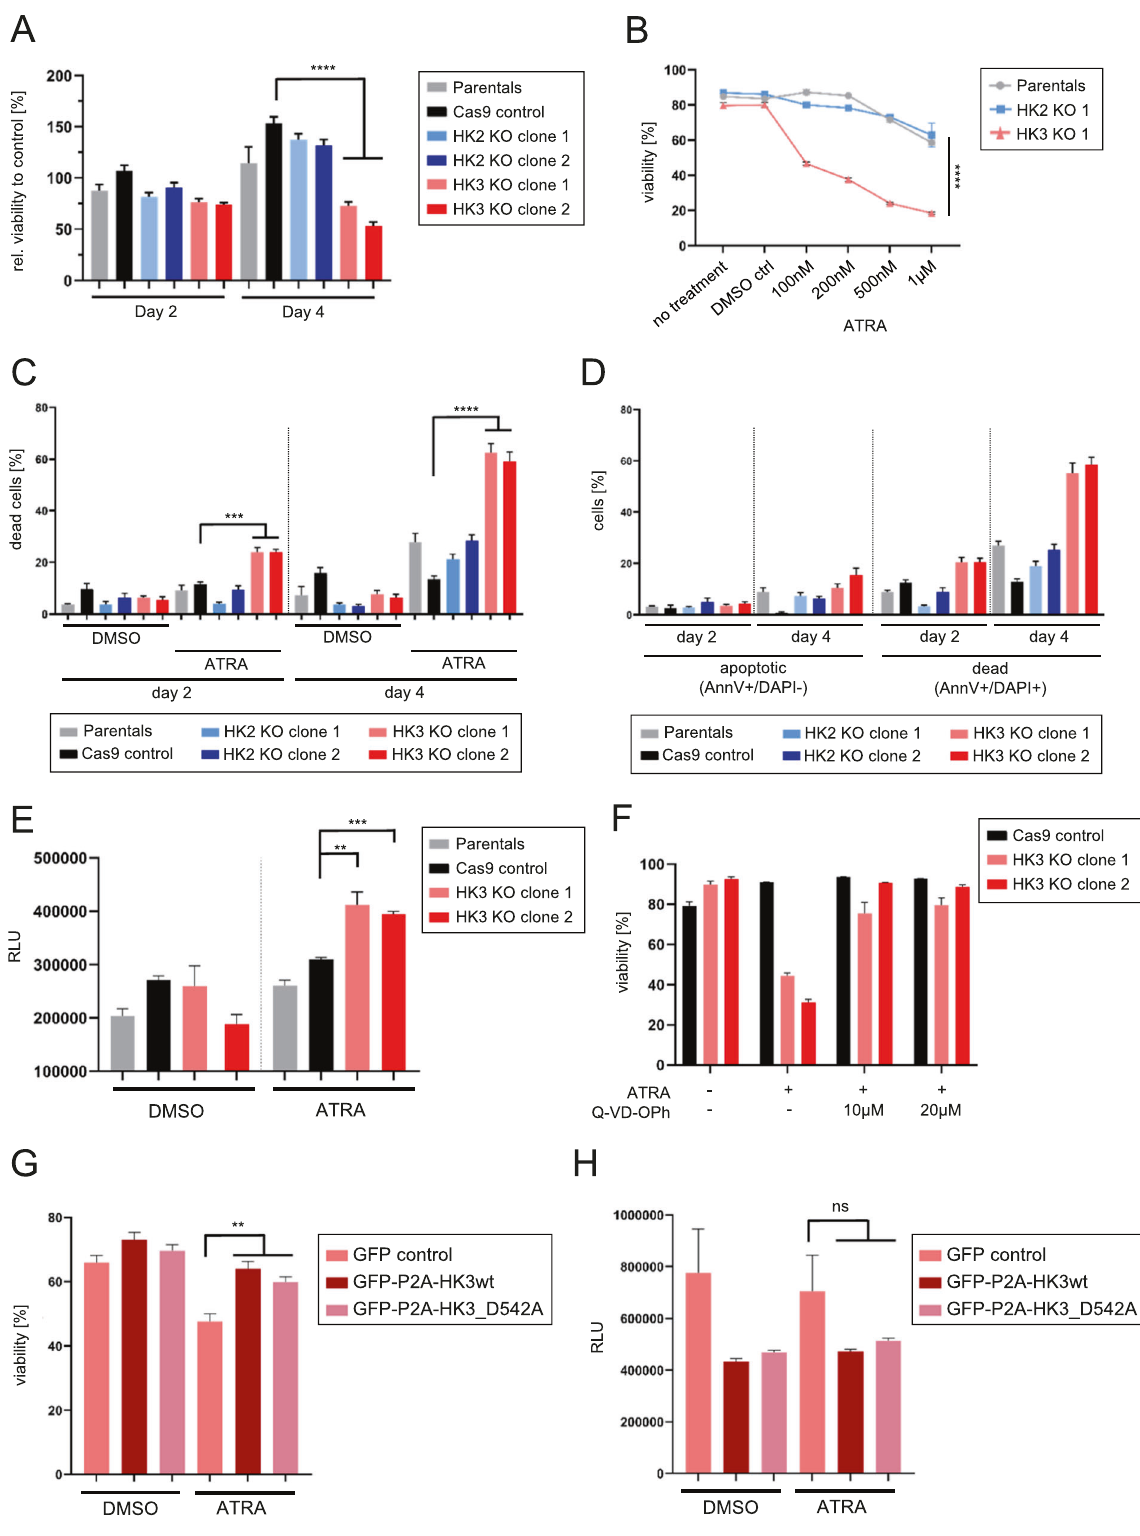
human plasma [36]. Similar glycolytic effects were observed with 50% reduced glucose levels (Fig. S2B). These results indicate that HK3 was dispensable for glycolytic activity in different AML cell lines, while HK2 was the glycolytically active HK